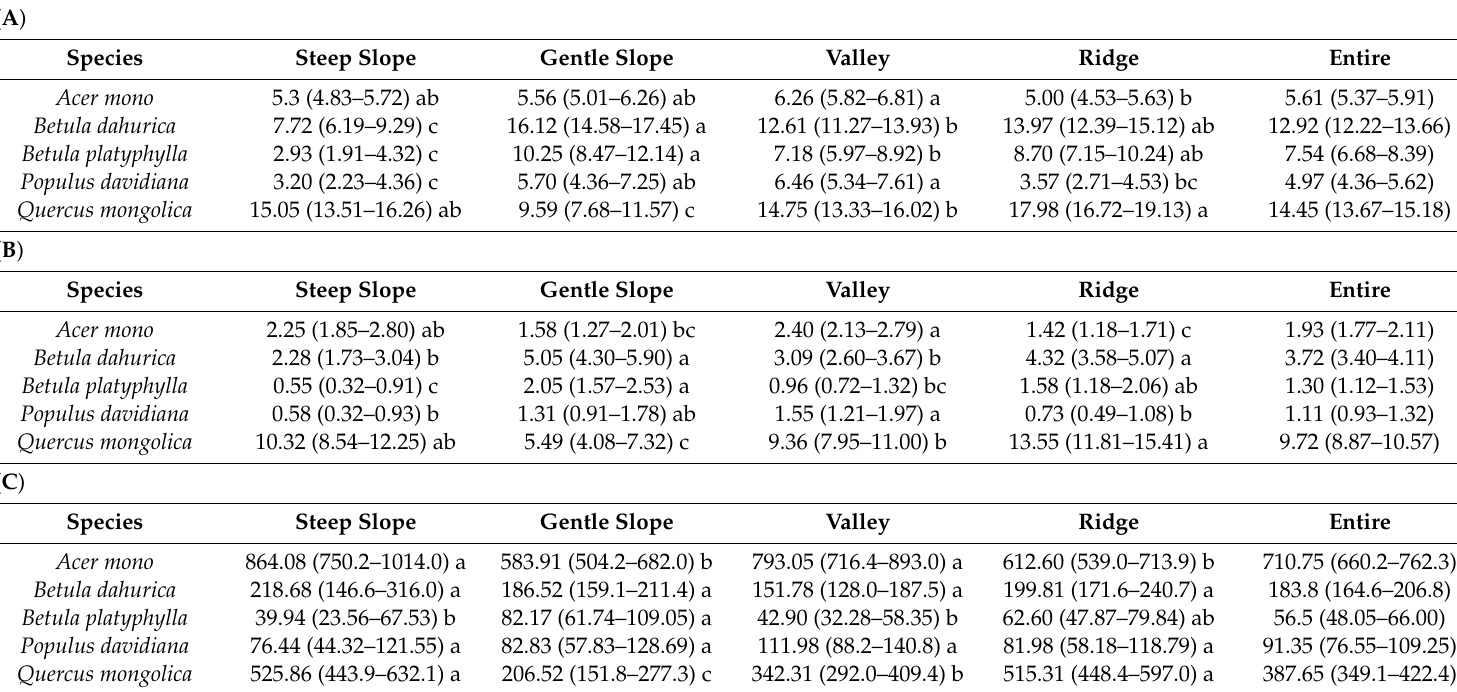
Table 3. Quadratic mean diameter ( A , cm), basal area ( B , m 2 / ha) and density ( C , trees / ha) of the five most common tree species in the four di ff erent habitats and the entire 20-ha DLS plot